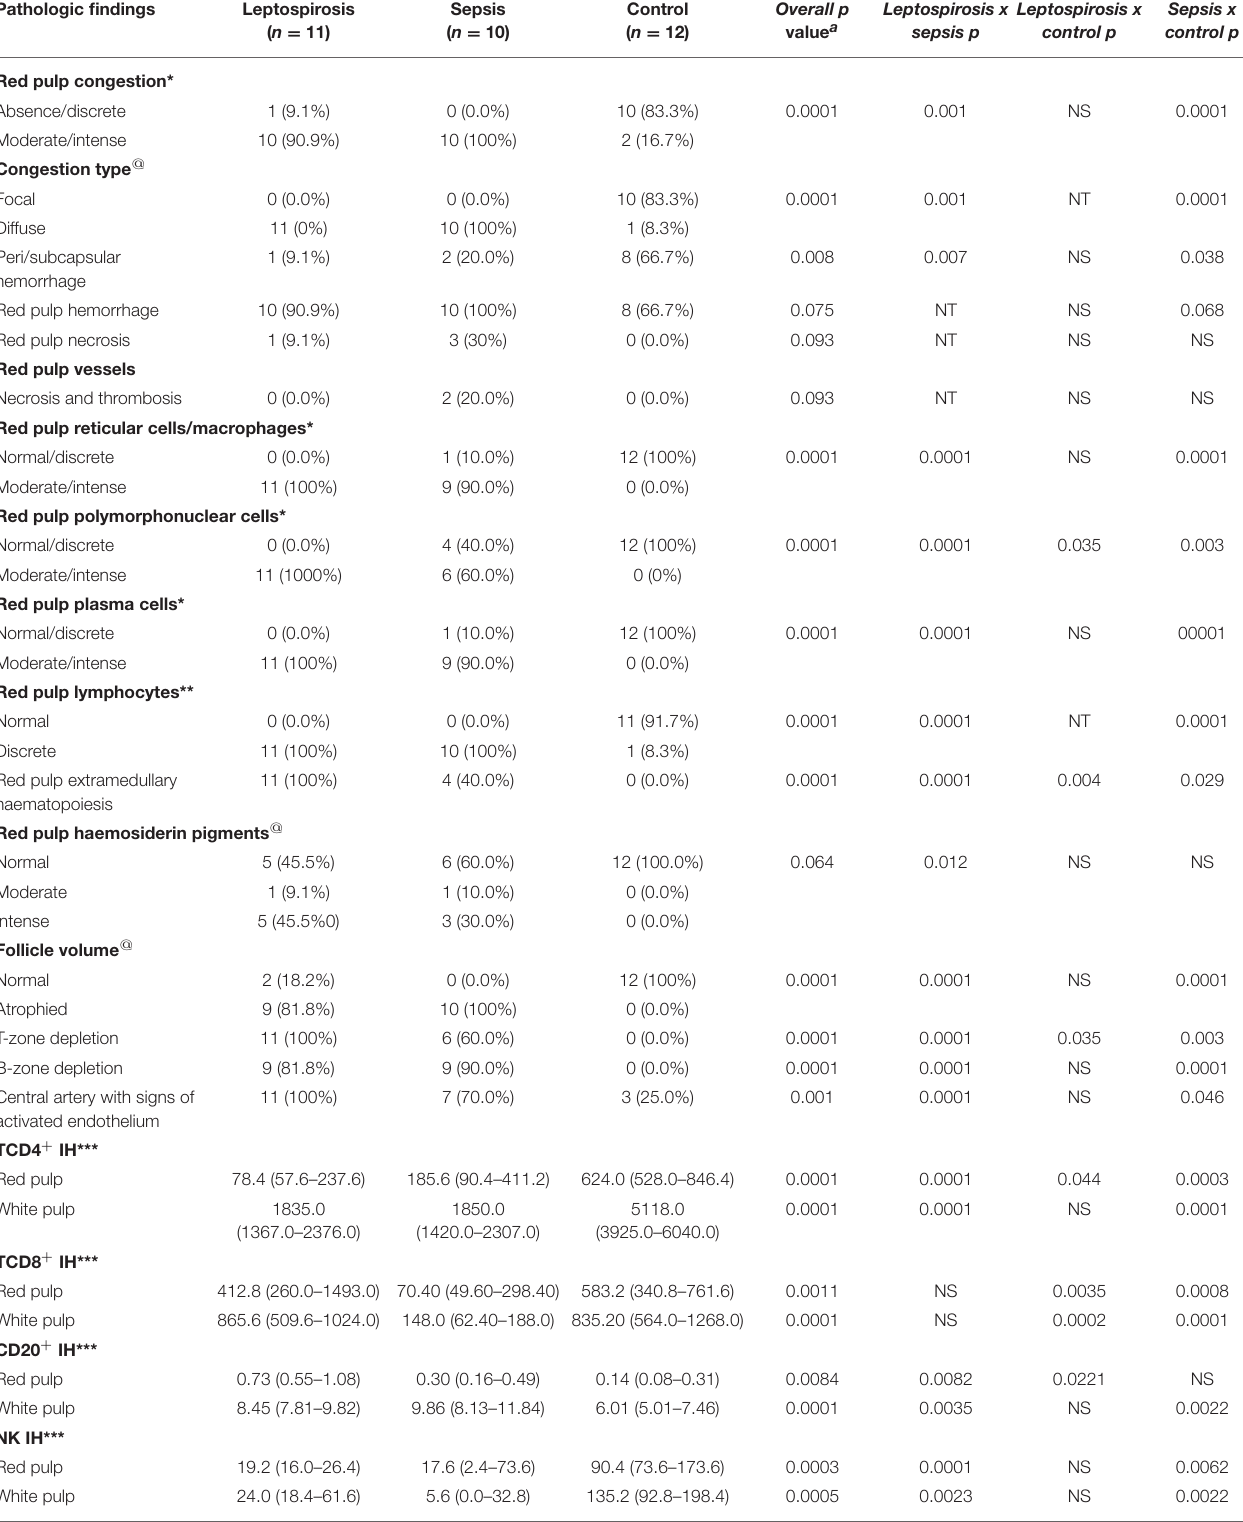
TABLE 5 | Histological and immunohistochemical findings in the spleen of patients with severe leptospirosis (with pulmonary hemorrhage and shock), sepsis or control. Pathologic findings Leptospirosis ( n =